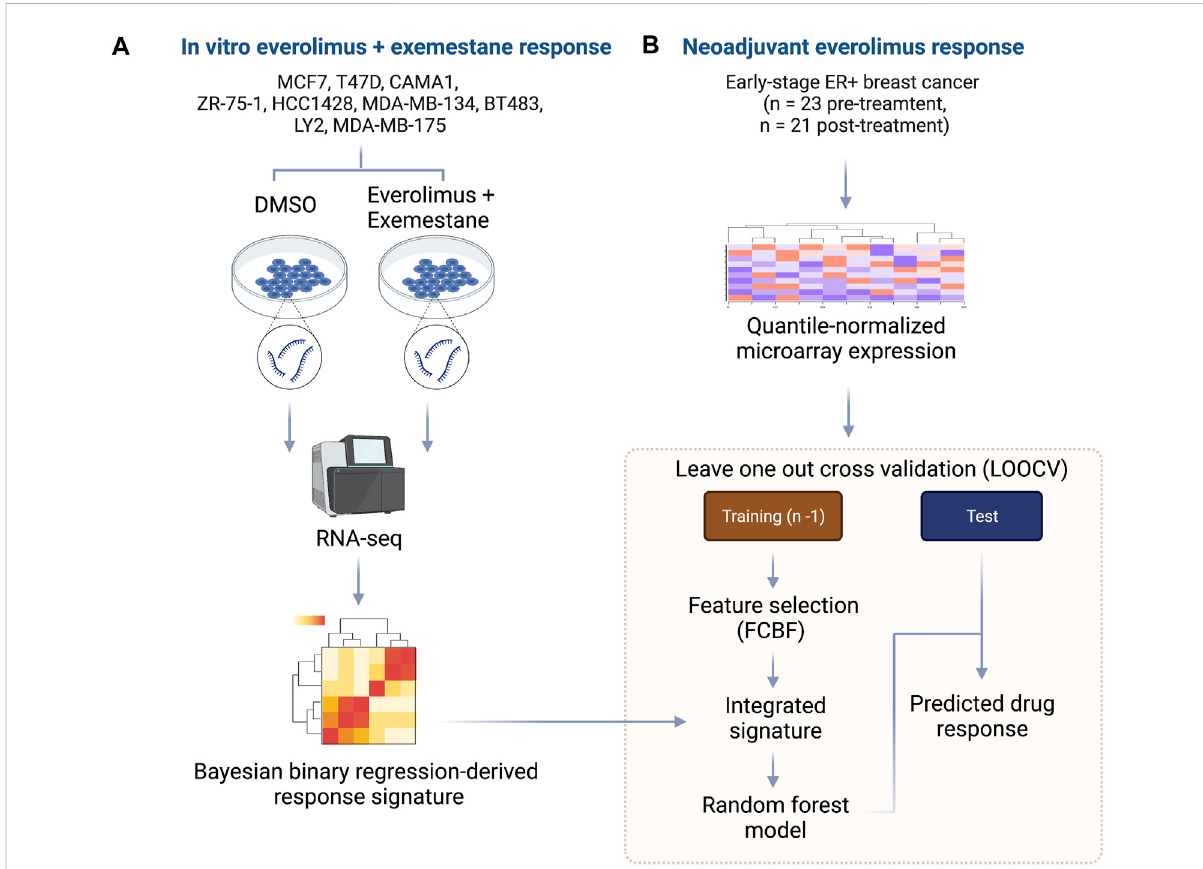
FIGURE 1 OutlineofintegrativeapproachformTORinhibitorbiomarkerdevelopment. (A) The invitro signaturewasdevelopedusing9ER+ breastcancer celllines.EachcelllinewastreatedwitheitherDMSOoreverolimusplusexemestane.TotalRNAwasextracted,andcDNAlibrarieswerepreparedfor RNA-seq. The raw transcripts were pre-processed, followed by quantile normalization and feature selection using the Bayesian binary regression framework. (B) Microarray data from early-stage ER+ breast cancer patients treated with neoadjuvant everolimus were pre-processed and analyzed within a leave-one-out cross-validation (LOOCV) framework. Each iteration of the LOOCV generated a list of features correlated with response. These features were integrated with the response signature derived from cell lines to obtain an integrated signature. The integrated signature was then used as a set of predictors in random forest model to predict the response in the test